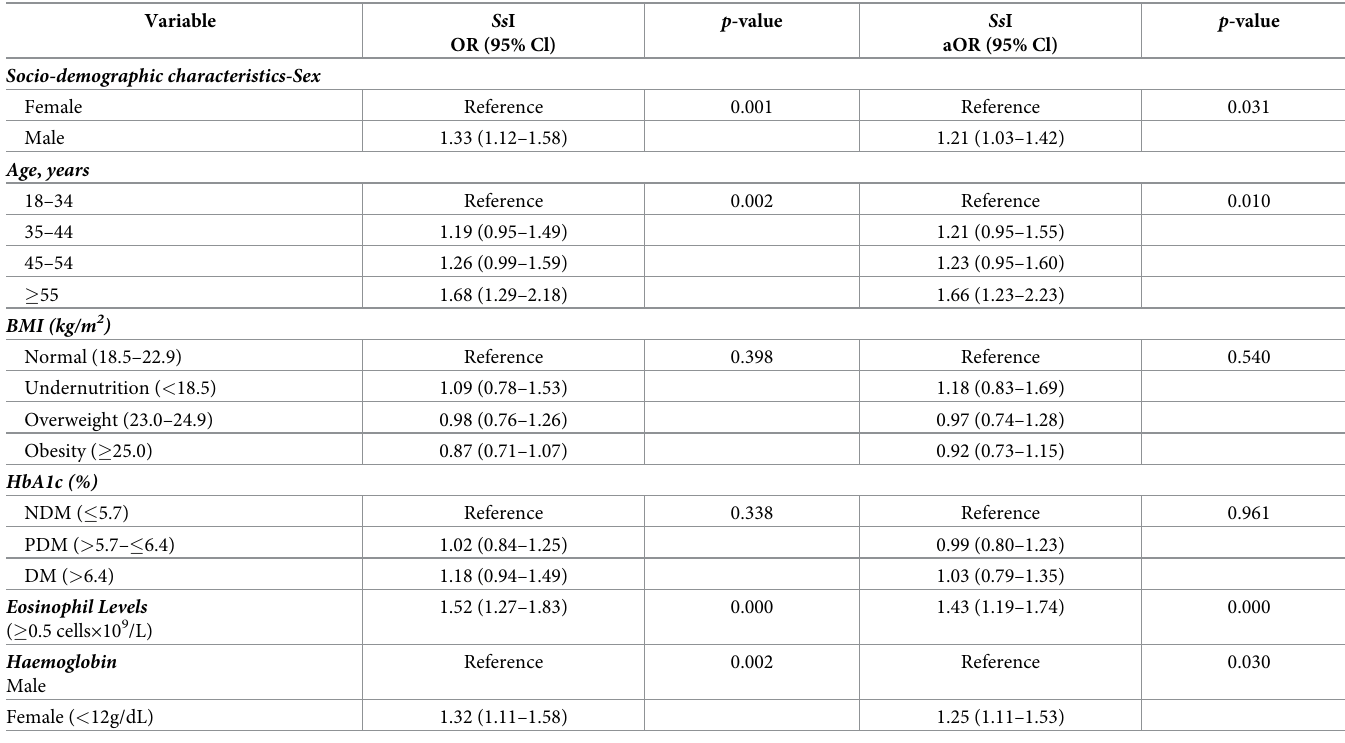
Table 2. Association of clinical co-morbidities with Strongyloides stercoralis infected South Indian adult population enrolled between 2013 and 2020.